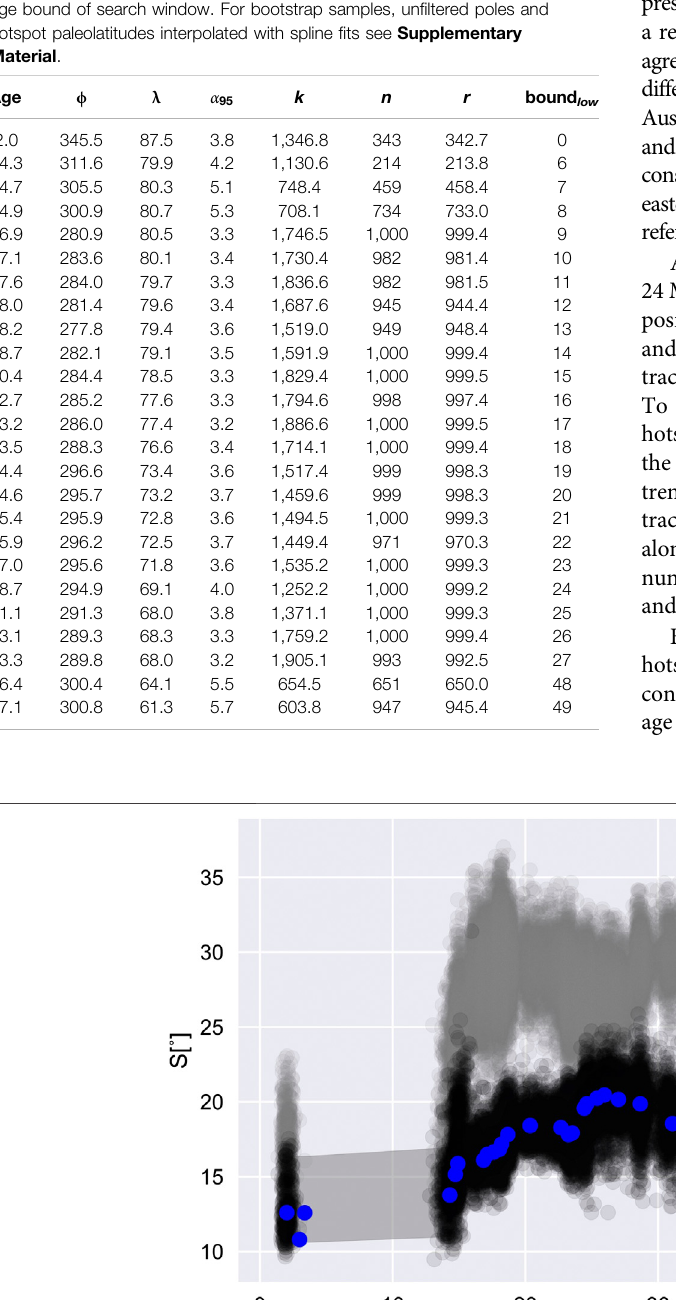
Frontiers in Earth Science |